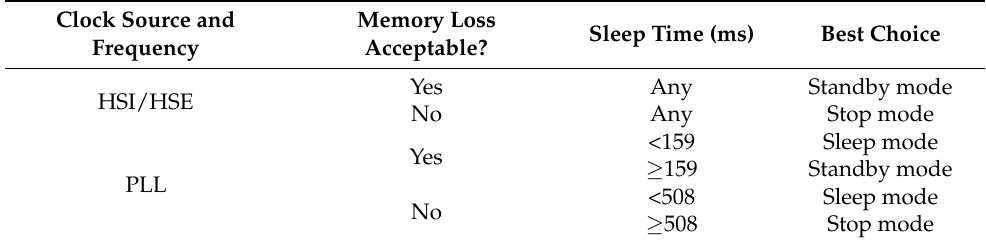
Table 5. Best choice of STM32F407 power-saving modes under different conditions. Clock Source